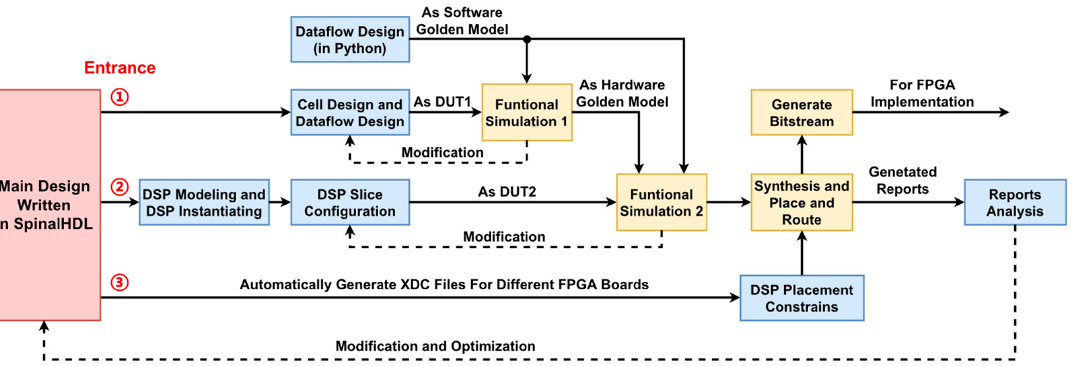
Figure 2. The flow diagram of the proposed design flow. The three main entrances in the design flow are marked by serial numbers ( 1 (cid:13) – 3 (cid:13)